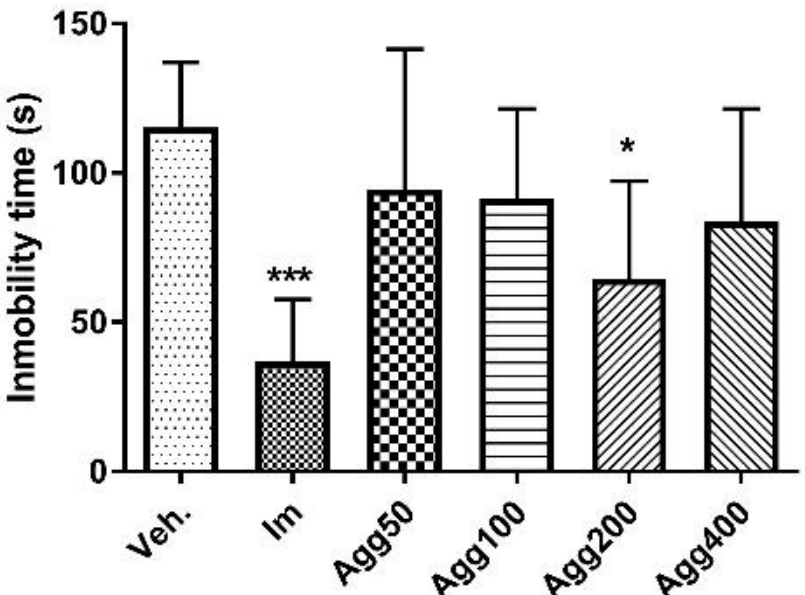
Figure 3. Immobility time (s) in the forced swimming test for the groups ( n = 6) treated orally with three doses in a 24-h period of Aloysia gratissima var. gratissima (Agg). Im.: imipramine. Veh: tween 80, 10%. The data correspond to the mean ± SD. One-way ANOVA and Dunnett’s post hoc test were performed. * p < 0.05; *** p < 0.001.